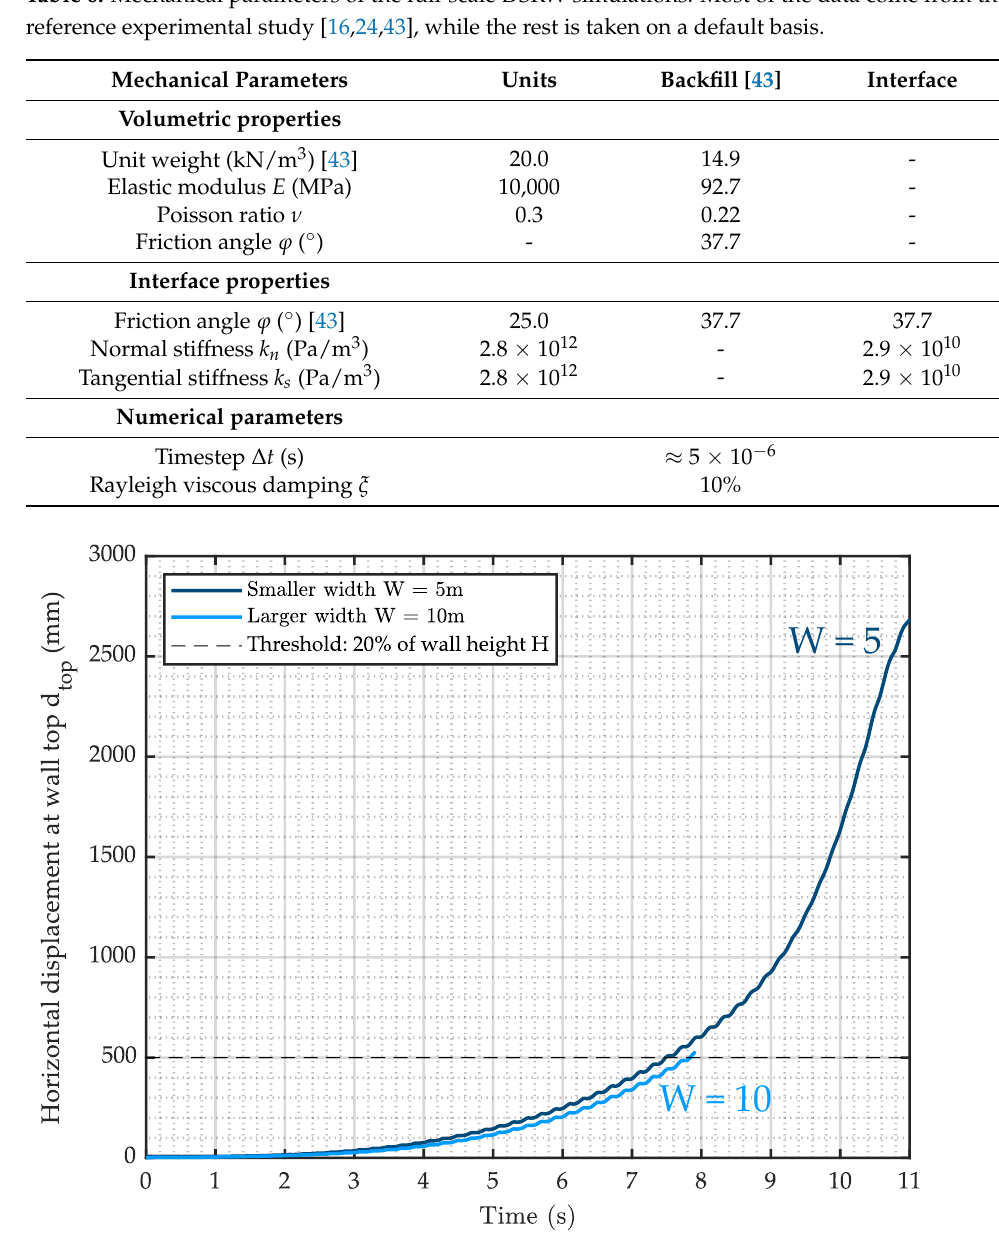
Figure 10. Comparison of the responses given by the numerical simulations of DSRW1 for two backfill widths